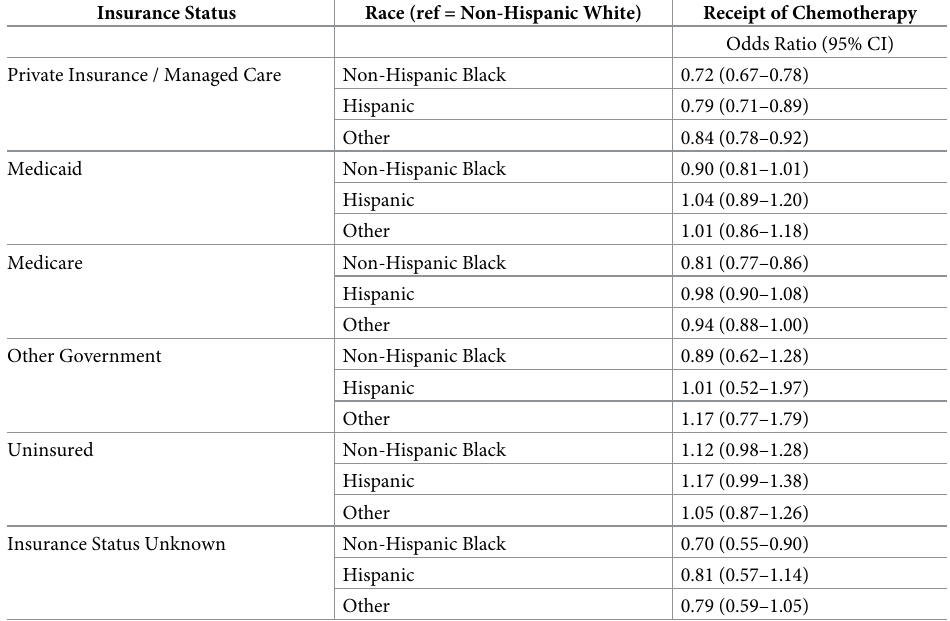
Table 3B. Adjusted odds ratio of receipt of systemic chemotherapy among non-hispanic black, hispanic, and other race compared to non-hispanic white patients stratified on insurance status based on the joint effects model a .